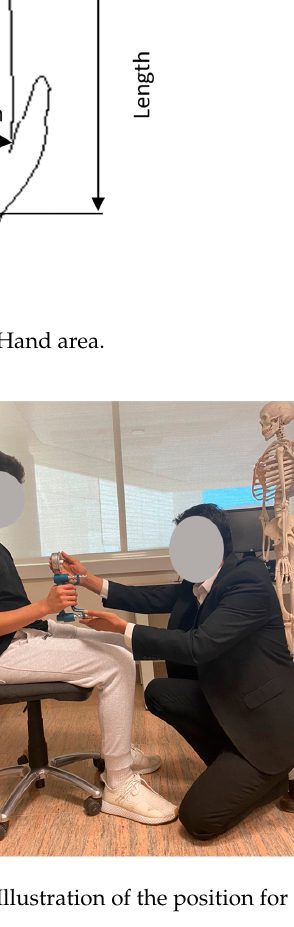
Figure 2. Illustration of the position for the measurement of Grip Strength.